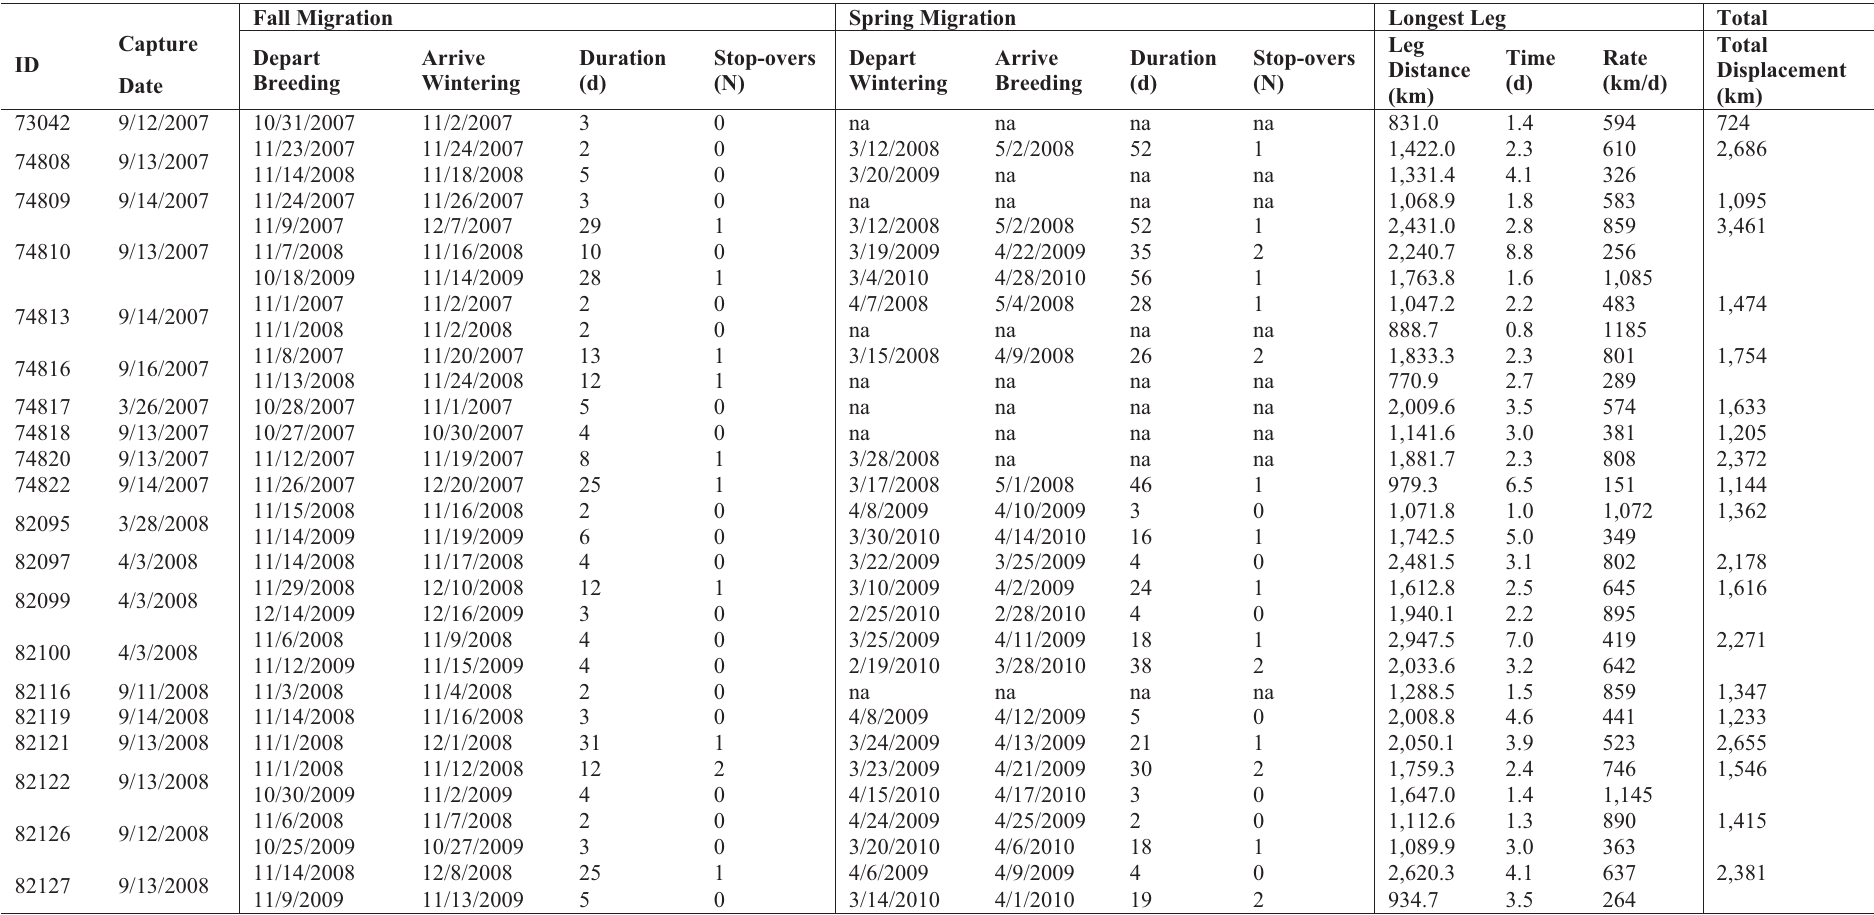
Table 3. Migration chronology and movement rates of ruddy shelducks marked at Qinghai Lake, China in 2007 – 2008. Dates, duration, and number of stopovers are reported for spring and fall migration. Longest leg (longest flight between two consecutive stationary areas, i.e. , stopovers, breeding, or wintering sites) and corresponding flight time, and total displacement (Euclidean distance from northern-most to southern-most points) are also